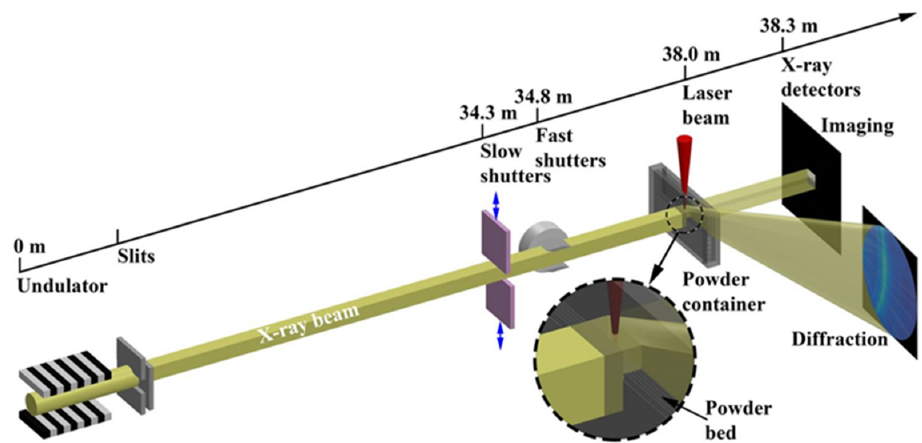
Figure 7. Schematic of the high-speed X-ray imaging and diffraction experiments on laser powder bed fusion process at the 32-ID-B beamline of the Advanced Photon Source. A pseudo-pink beam with a first harmonic energy of 24.4 keV ( λ = 0.508Å) is generated by a short-period undulator. The laser irradiates the micro-powder bed sample from the top, the X-rays penetrate from the side of the sample. The imaging and diffraction detectors are placed approximately 300mm downstream from the sample. The inset surrounded by the dashed circle enlarges the view of the laser-sample and X-ray-sample interaction. The distance of each component from the source is labeled on top. (Reprinted with permission from Ref. [28]. Copyright 2017 Springer